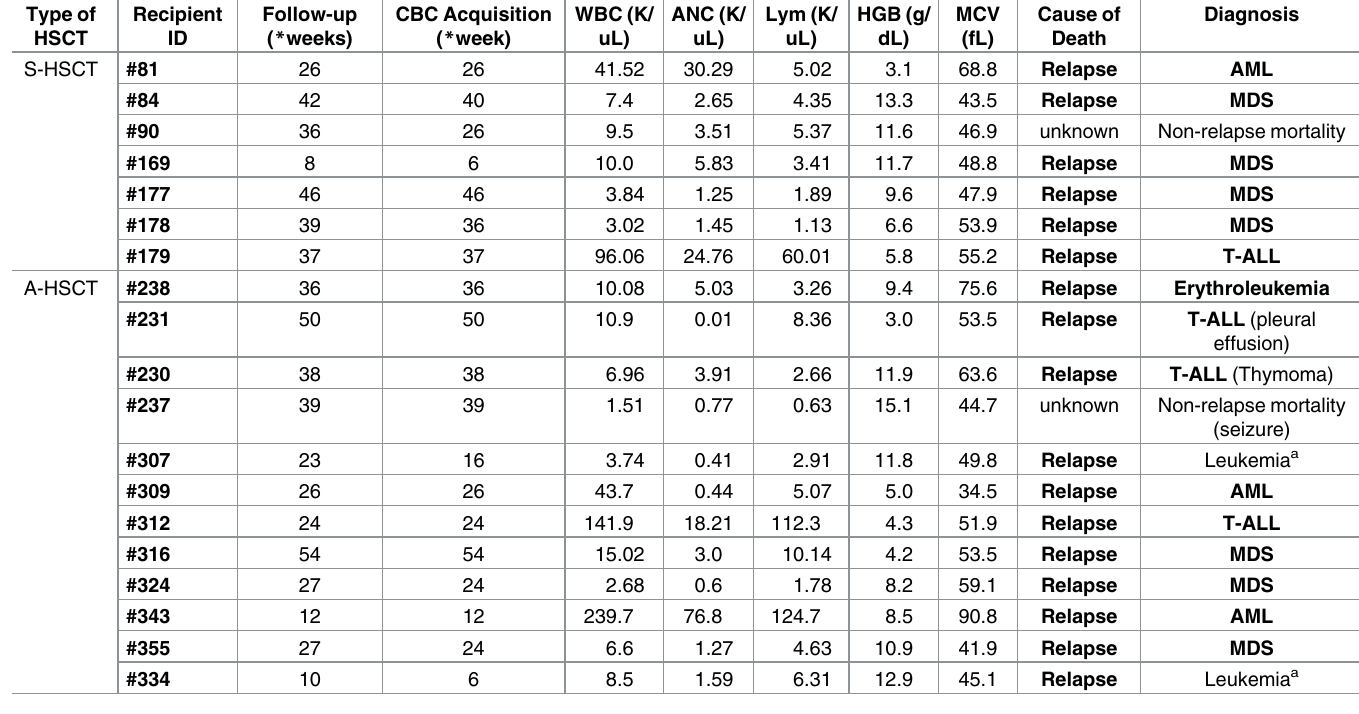
Table 1. Clinical outcome of therapeutic HSCT in NHD13mice with MDS.